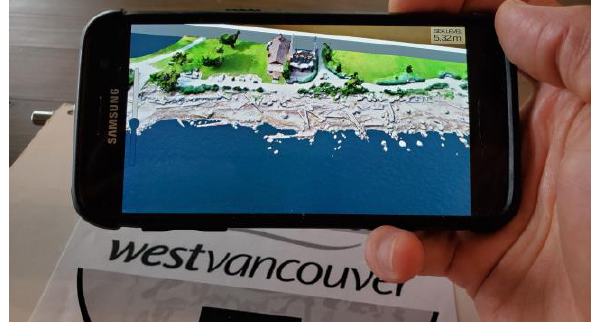
Figure 5. Our interactive tabletop AR prototype – allowing on-the-fly control of a moveable sea surface intersecting with 1cm resolution intertidal